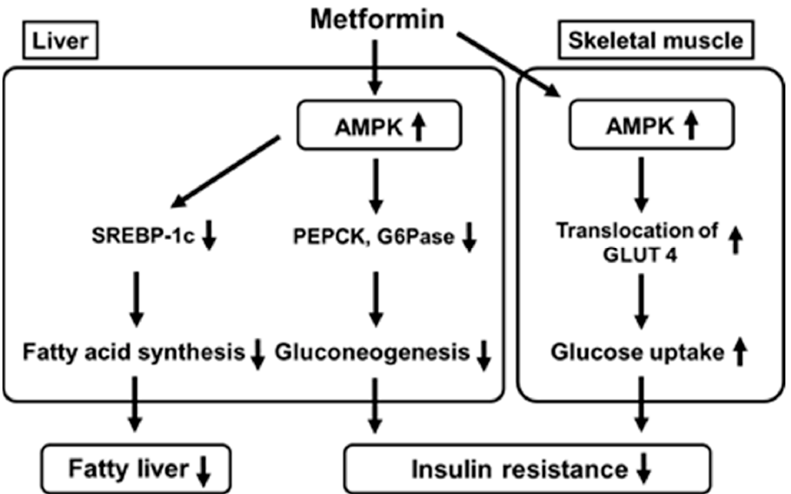
Figure 1. Metformin activates AMP-activated protein kinase (AMPK) in the liver which leads to suppression of fatty acid synthesis and gluconeogenesis. Metformin also activates AMPK in skeletal muscle which increases translocation of glucose transporter 4 to the cell membrane and thereby increases glucose uptake. SREBP-1c, sterol regulatory element binding protein-1c; PEPCK, phospho- enolpyruvate carboxykinase; GAPase, glucose 6-phosphatase; GLUT 4, glucose transporter 5. Metformin Suppresses Glucagon Signaling in the Liver by Suppressing Adenylate Cyclase Which Leads to Suppression of Gluconeogenesis in the Liver Glucagon is secreted from pancreatic α -cells and functions as one of the counter-reg- ulatory hormones, leading to an increase in blood glucose levels. As one main mechanism